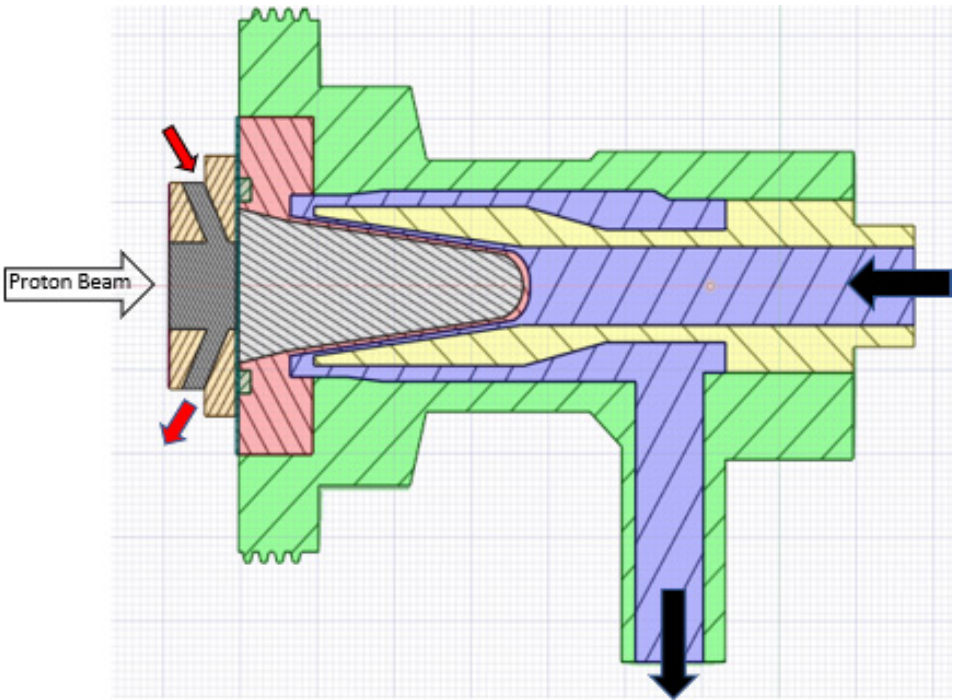
Figure 1. Schematic of the liquid target system composed by the niobium conical target (red), the target window (dark green), the aluminum diffuser (yellow), the aluminum target support (light green), the aluminum window spacer (orange), the titanium entrance window (blue), the fluid domains, water cooling channels (purple), the helium cooling domain (dark grey), and the liquid target cavity (light grey). The inlet and outlet of both the coolants domains are represented by the black arrows (cooling water) and red arrows (cooling helium).